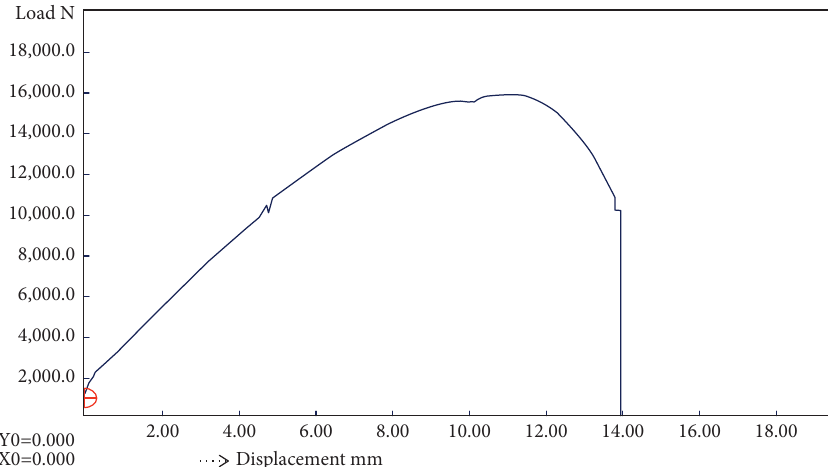
Figure 16: Load vs. displacement graph for double V butt joint.